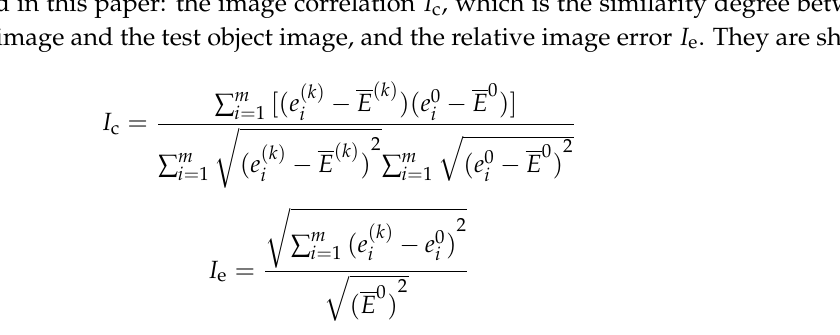
I by different algorithms. e